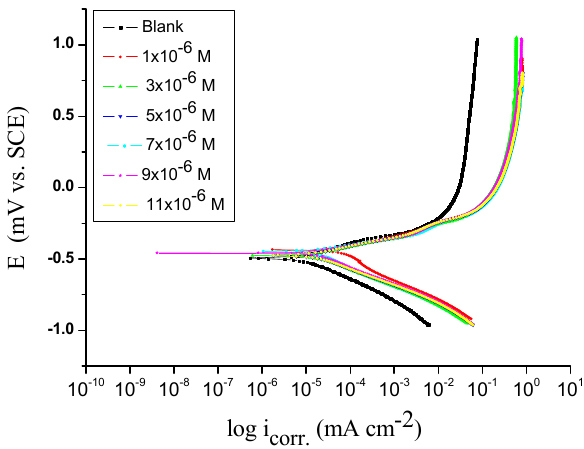
Figure 1. TP diagrams for the corrosion of Q235 steel in corrosive environments in the presence and lack of unlike dose of spiropyrazoles (1) at 25 ± 0.1 °C.